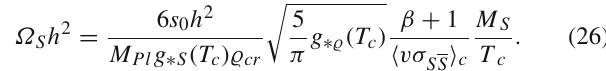
Fig. 1 Allowed values of the skyrmion parameter g 2 M S / T c ≤ 10